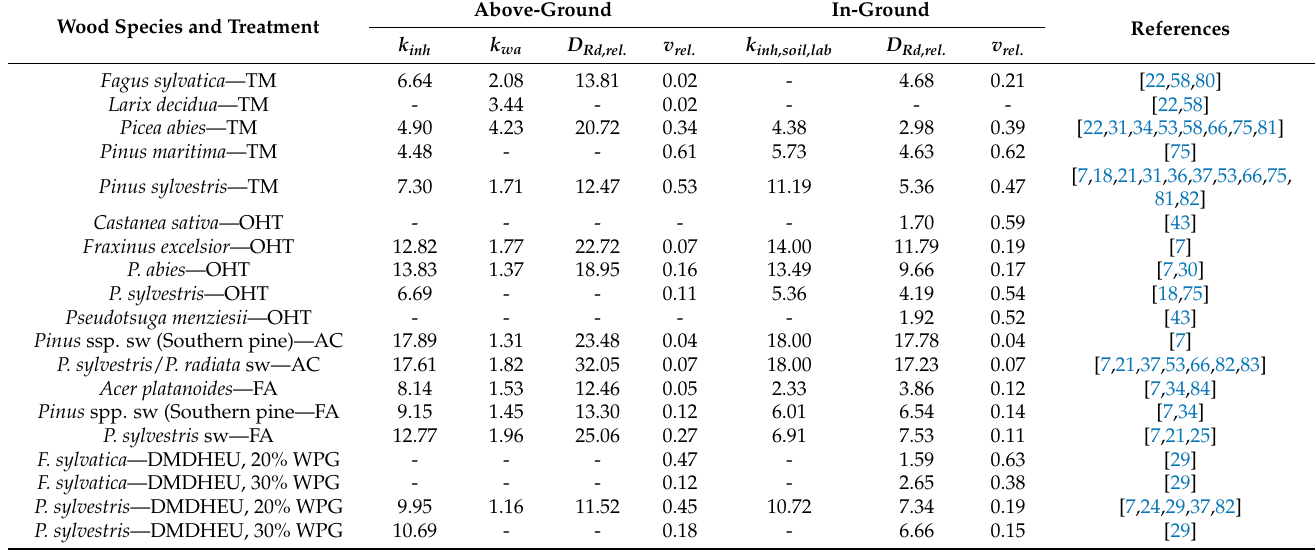
1 unpublished data by the authors. Table 3. Parameters for predicting the material resistance of modified timbers in- and above-ground. k inh = factor accounting for protective inherent properties based on white rot, brown rot, and soil contact tests; k inh,soil,lab = factor accounting for protective inherent properties based on laboratory test with soil contact and soft rot fungi; k wa = factor accounting for moisture performance (wetting ability); D Rd,rel. = relative resistance dose; v rel. = relative decay rate; sw = sapwood; TM= thermal modification; OHT = oil-heat treatment; AC = acetylation; FA = furfurylation; DMDHEU = treatment